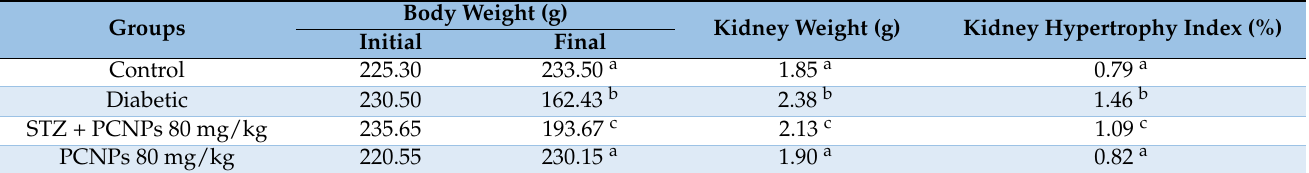
Table 2. Activities of PCNPs on body weight, kidney weight and kidney hypertrophy index of STZ-induced diabetic nephropathy in